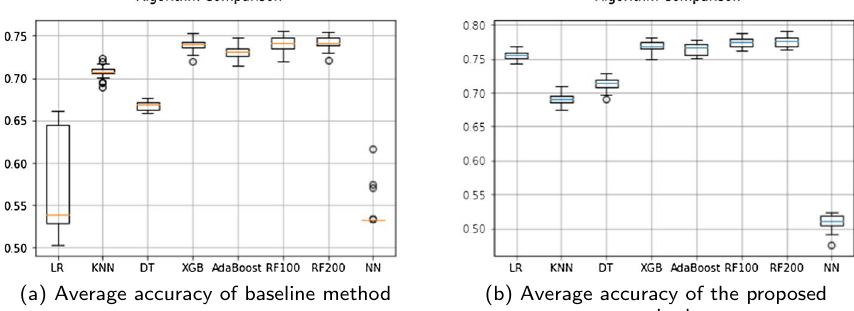
Fig. 16 Comparisons of average accuracy of all seven learning